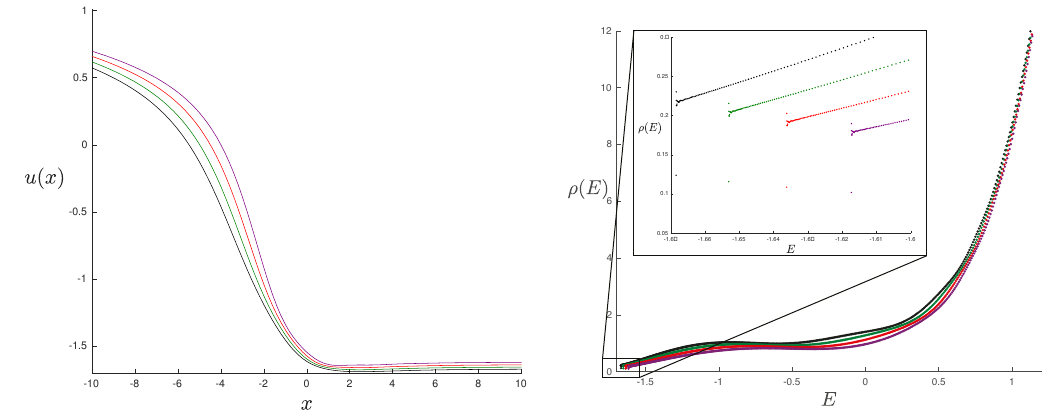
Figure 12. On the left are numerical solutions for the potential u ( x ) obtained by solving the string equation (2.15) for α = 1 / 4 in the k max = 7 truncation and λ beyond the window λ ∈ (0 . 03480 , 0 . 36733) in which u 0 ( x ) is multi-valued (see figure 9). Here λ = 4 (purple), λ = 4 . 5 (red), λ = 5 (green) and λ = 5 . 5 (black). On the right the associated spectral densities obtained from (2.6) and plotted using the same